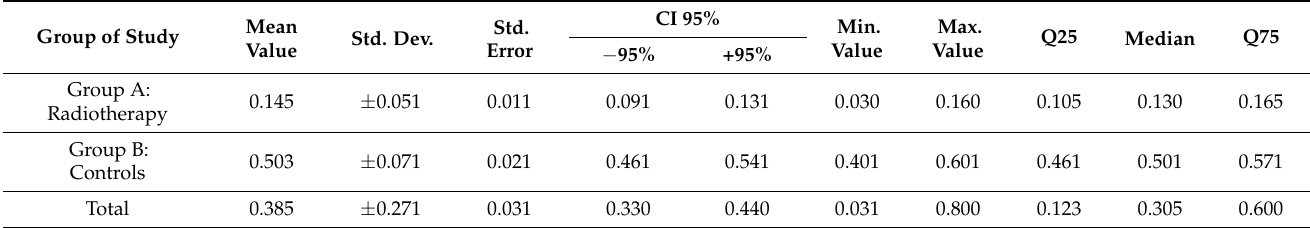
Table 4. The central tendency indicators of resting salivary flow